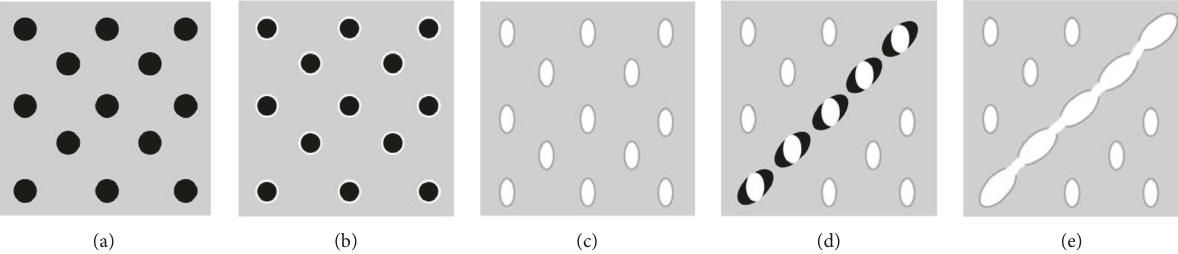
Figure 1: Process of crack formation: (a) inclusions, (b) cavity nucleation, (c) cavity growth, (d) cavity necking, and (e) cavity